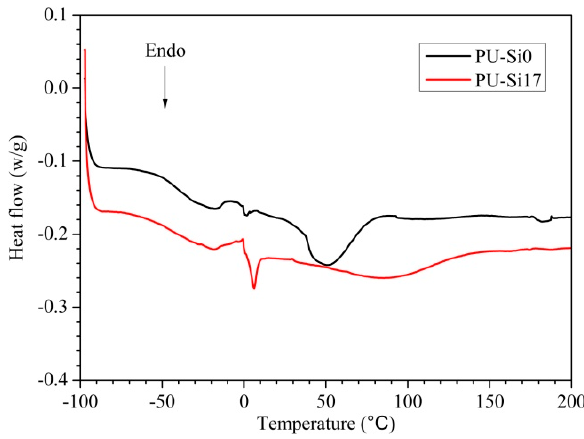
Figure 3. Differential scanning calorimetry (DSC) curves of PU-Si0 and PU-Si17.